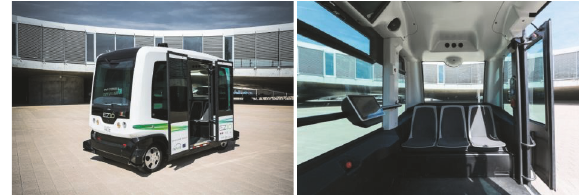
Figure 1: Photos included at the top of the questionnaire [39, 40].